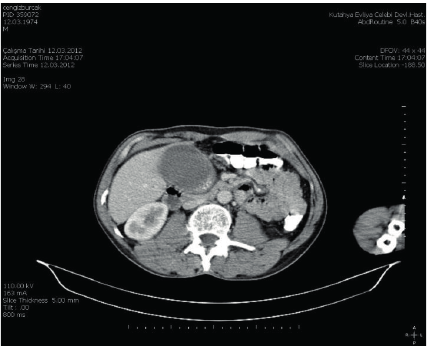
Figure 1: Omental infiltration and suspected invasion of hepatic flexure and right transvers colon.